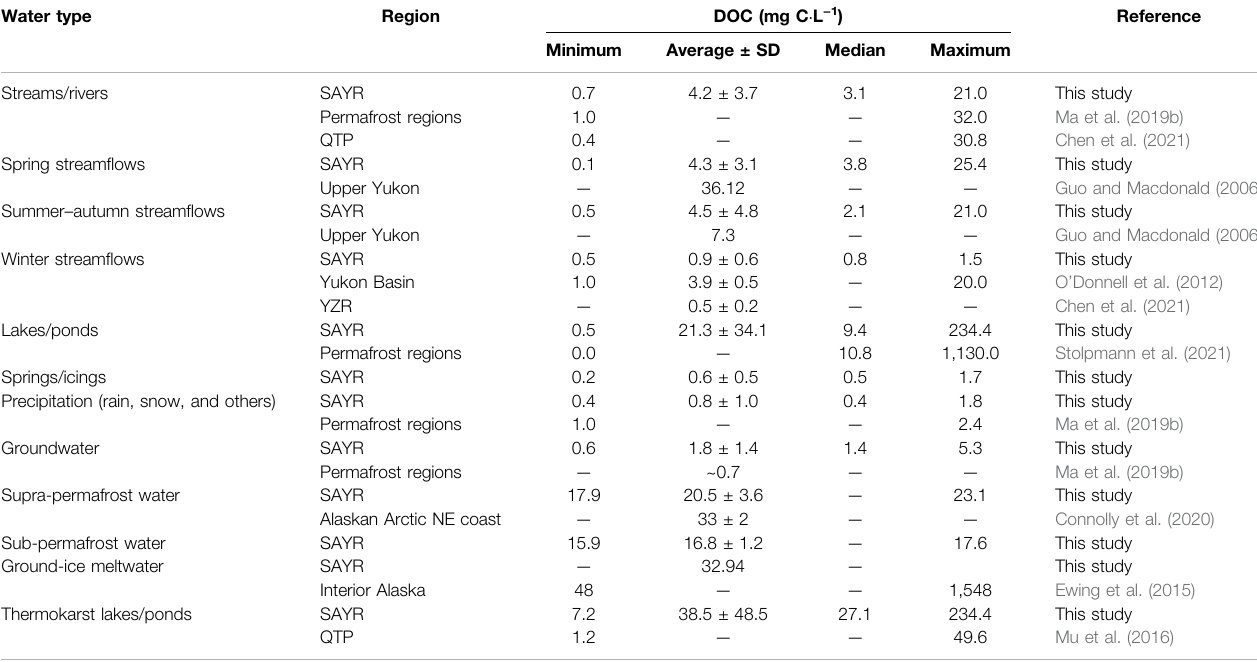
TABLE 2 | List of minimum, average, median, and maximum values of dissolved organic carbon (DOC) concentrations in each water type in the source area of the Yellow River (SAYR) above the Tanag hydrological station in Qinghai Province, China. Water